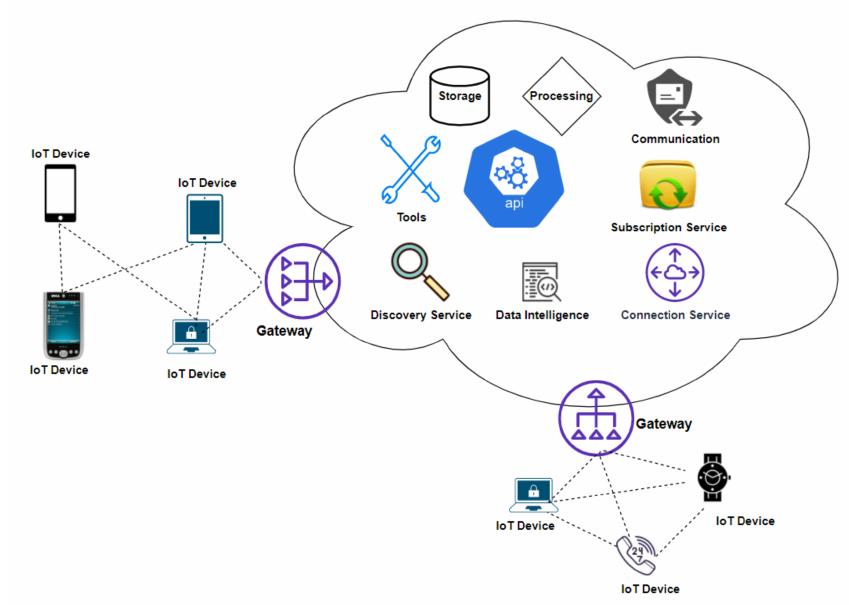
Figure 1. Cloud-based IoT